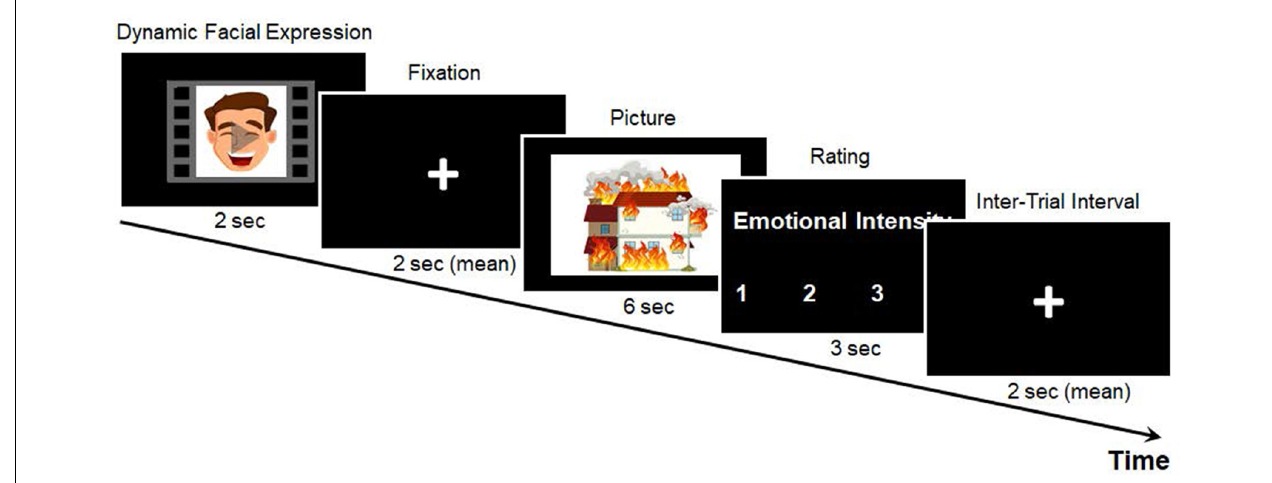
FIGURE 1 | Example of the emotional intensity rating task. Example stimuli are animated for demonstration